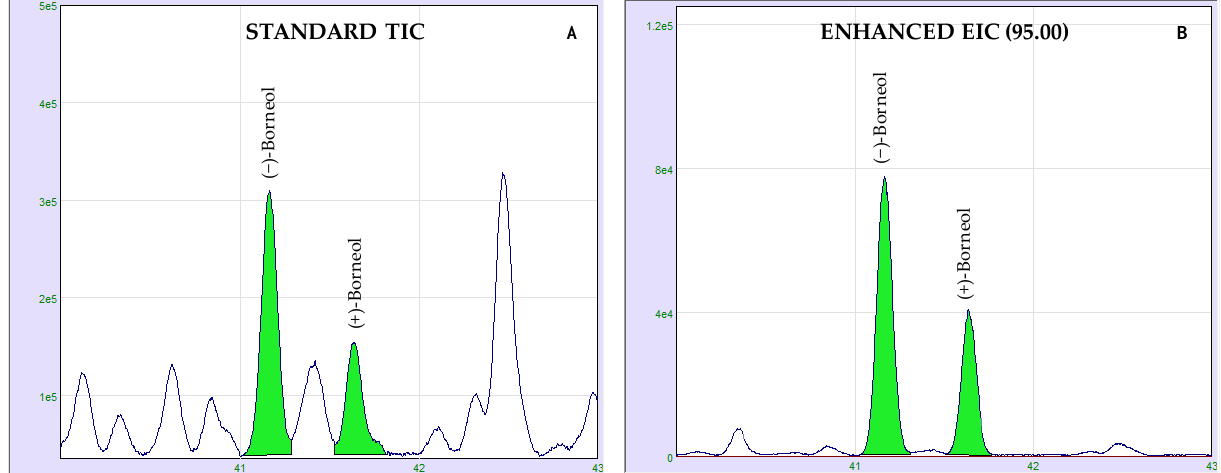
Figure 5. Enantio-GC comparison of zoomed borneol region of standard total ion current (TIC) ( A ) and enhanced extracted ion current (EIC) ( B ) in cannabis EO. Borneol enantiomer ratio was determined monitoring the 95 m / z fragment ( B ).